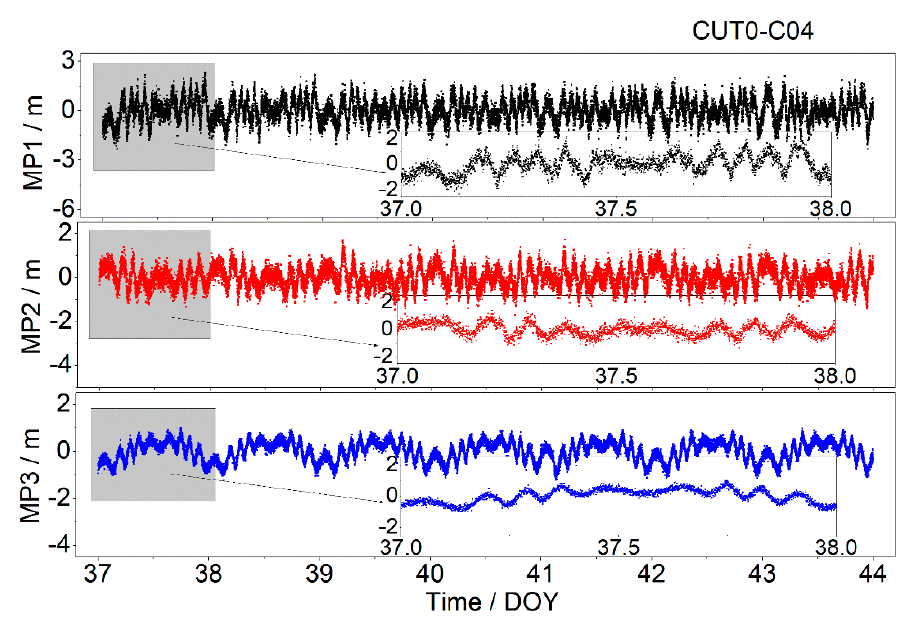
Figure 3. Multipath series of MP1 (top), MP2 (middle), and MP3 (bottom) for C04 at CUT0 station from date-of-year (DOY) 37 to 44 in 2017.